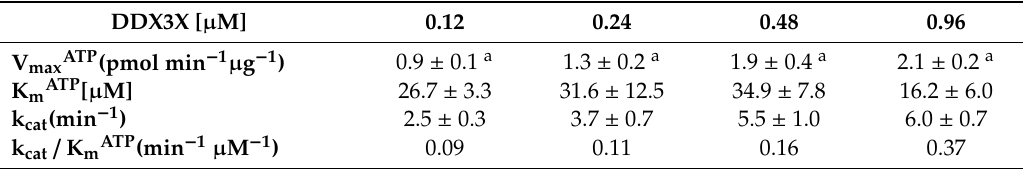
Figure 4. Kinetic analysis of CK1 ε acting on ATP and DDX3X. ( A ) Kinetic analysis of CK1 ε towards ATP increasing concentrations at fixed DDX3X concentrations. ( B ) Kinetic analysis of CK1 ε towards DDX3X increasing concentrations at fixed ATP concentrations. Reaction velocity rate (y axis) is represented as picomoles of incorporated phosphate on DDX3X per minute per microgram of enzyme (pmol / min / µ g). Data are representative of three independent experiments. Bars indicate mean ± SD. Table 4. Kinetic parameter values of CK1 ε as a function of varying ATP concentrations at fixed DDX3X amounts.